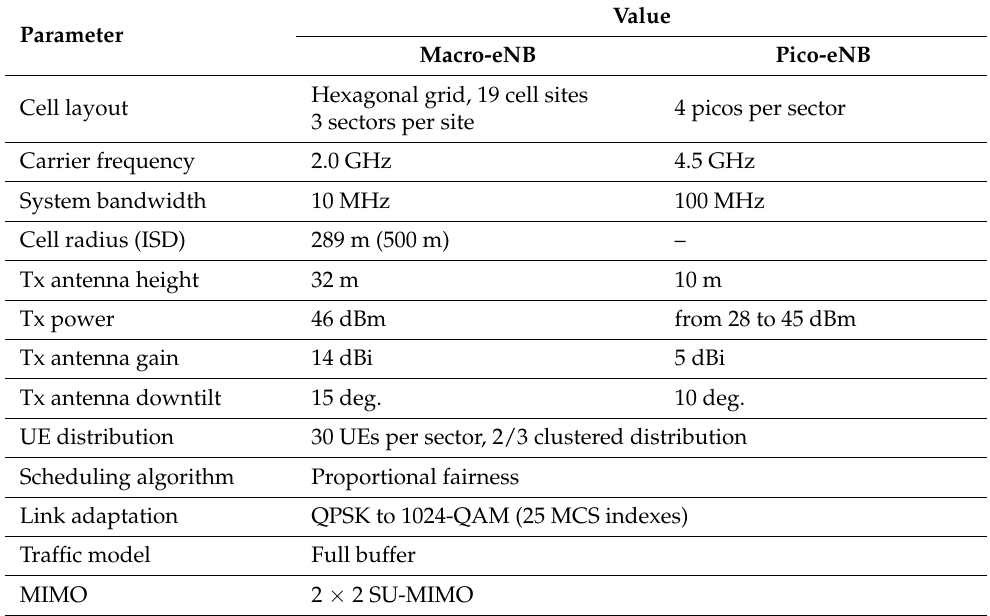
Table 1. Multiband HetNet model used in the simulation.